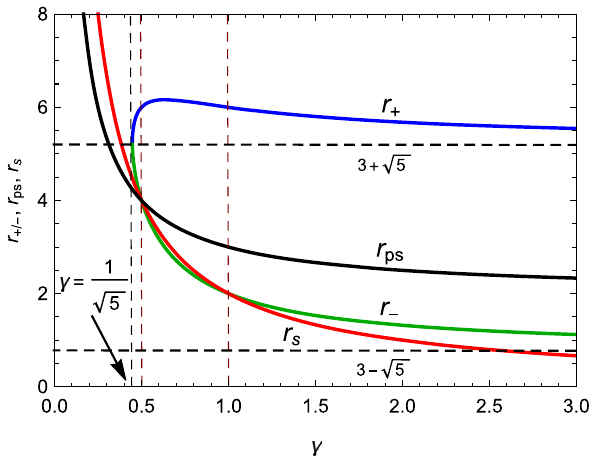
Fig. 7 Variations of r + (blue), r − (green), r s (red) and r ps (black) as functions of γ . We have considered M = 1 to obtain the plots